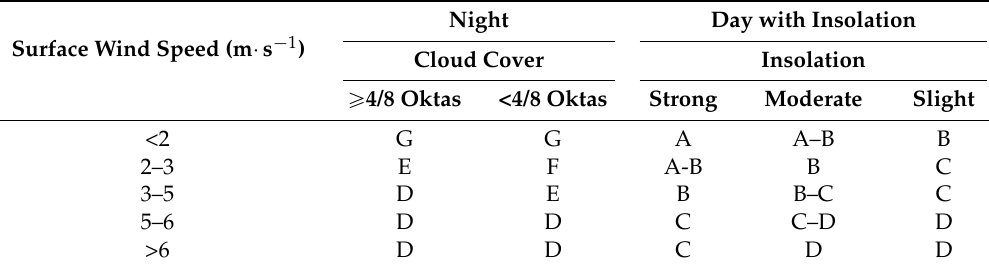
Table 3. Pasquill-Gifford Stability